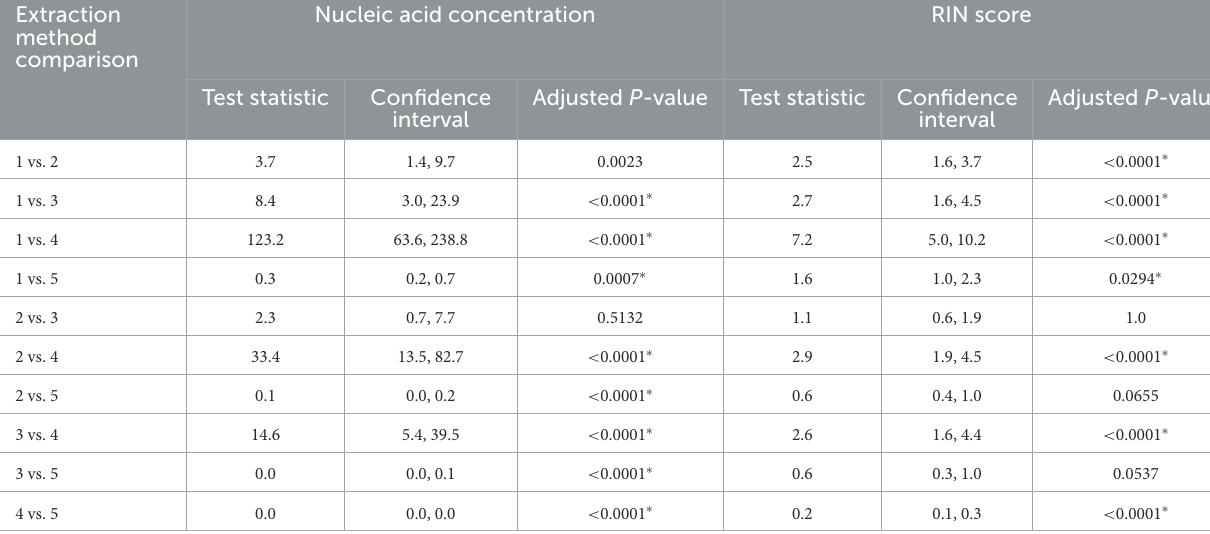
TABLE 3 Extraction method influences RNA integrity number (RIN) score.